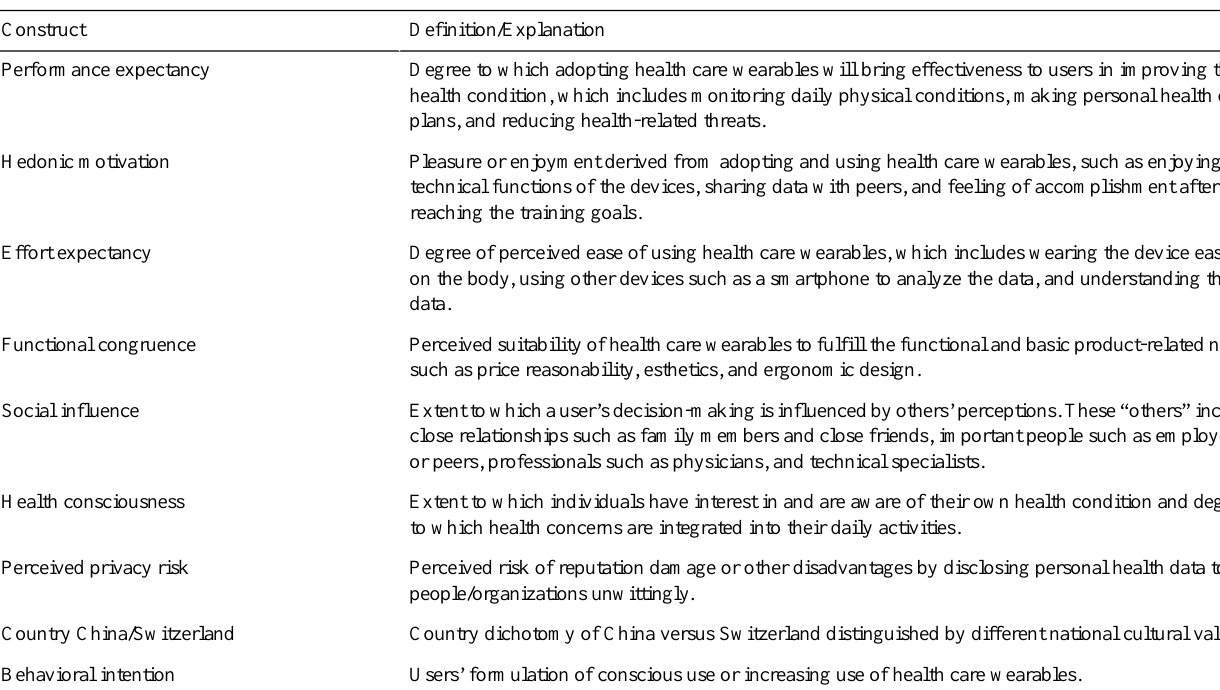
Table 3. Definitions of factors in the conceptual